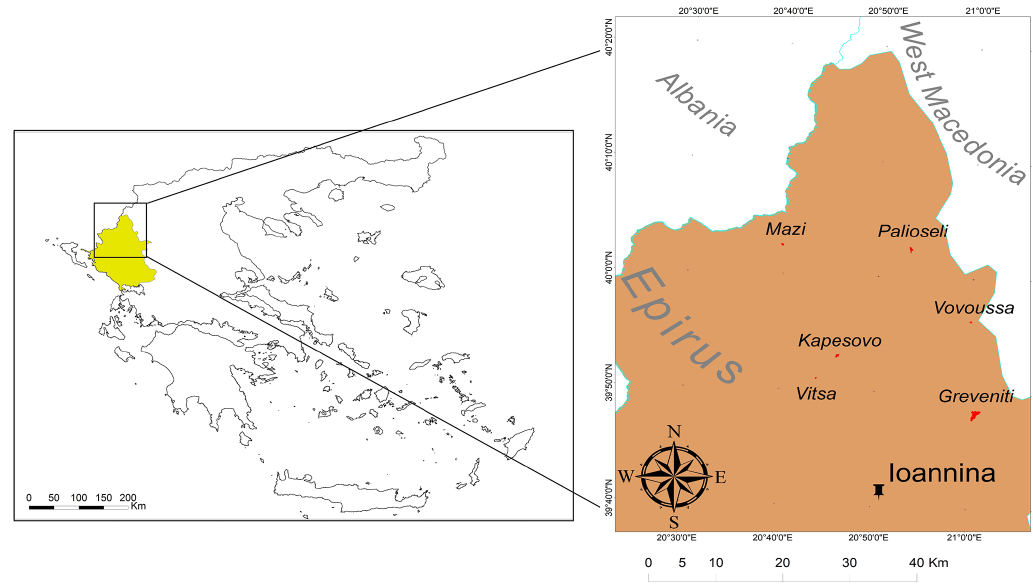
Figure 1. Location of the Epirus region in northwestern Greece and (inset) location of the six studied sacred forests and the capital of Epirus (Ioannina). © Adapted from the GADM